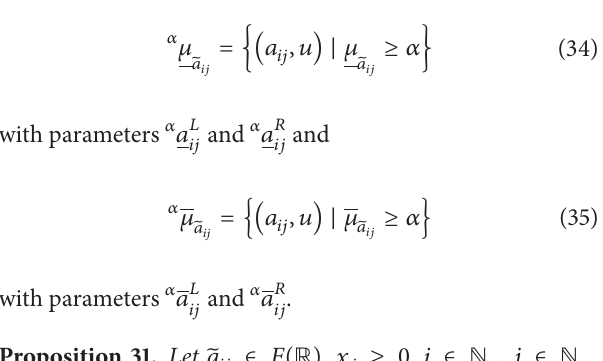
̃𝐴 𝐿 > ̃𝐵 𝐿 because .